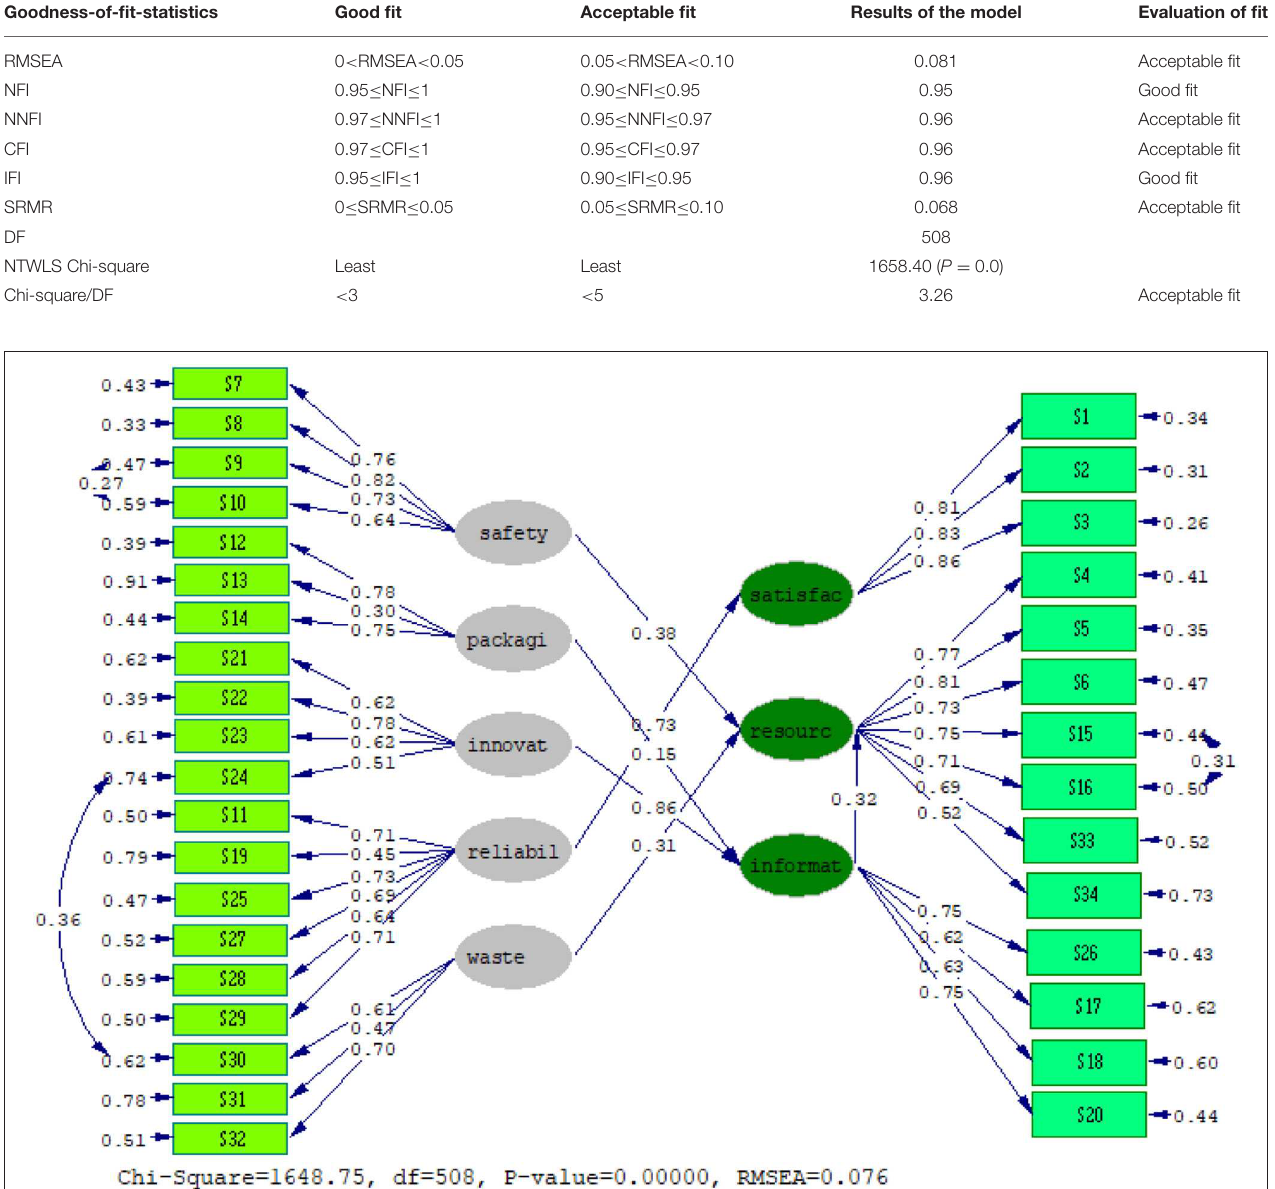
FIGURE 6 | Structural model of the sustainable food supply chain performance